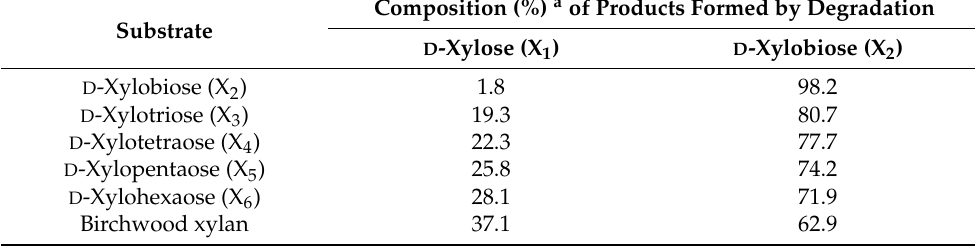
Table 4. Liquid chromatography (LC) analysis of the degradation products of β -1,4- D -xylosic materi- als by